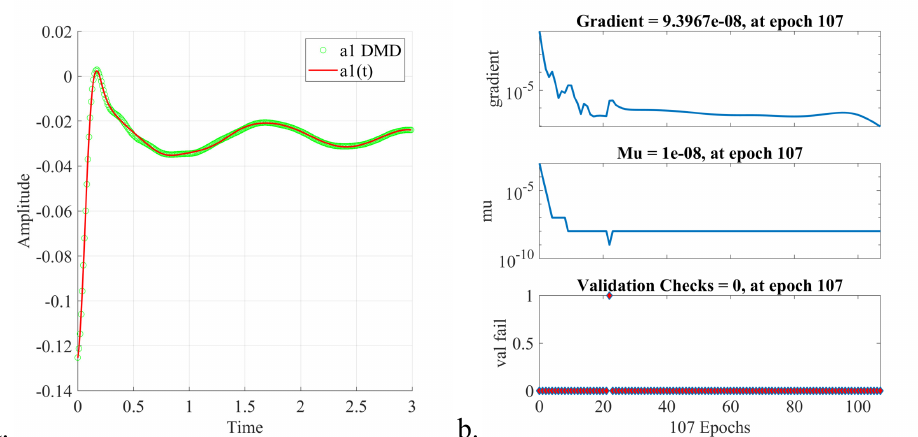
Figure 16. ( a , b ) The validation for the first temporal coefficient, as simulated response of the optimal NLARX estimator, in the case of experiment Re = 10 4